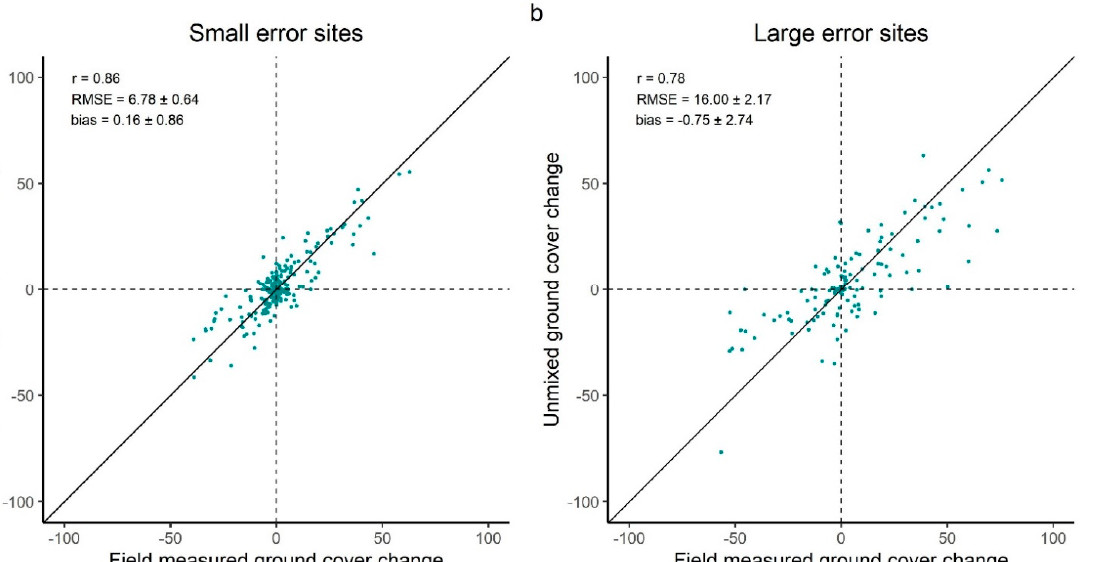
10 of 20 Pearson’s correlation coefficient (r), root mean square error (RMSE), and bias (calculated as the mean difference between observed and predicted) are displayed. Confidence intervals of 95% are shown for RMSE and bias. When analysing each fraction separately, some variability was detected across the field dataset and subsets. Results for the continental and dryland subsets were approxi- mately equal; however, subtle differences in model accuracy were observed for subre-